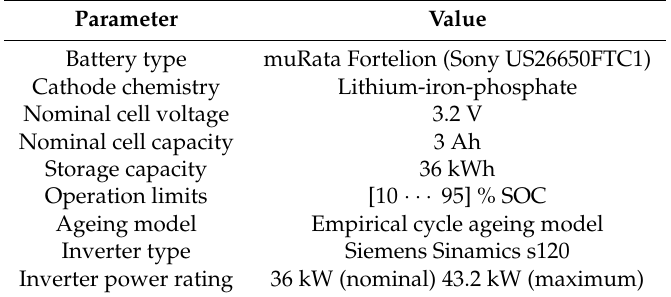
Table A1. Technical parameters of the battery and inverter system used for this study.